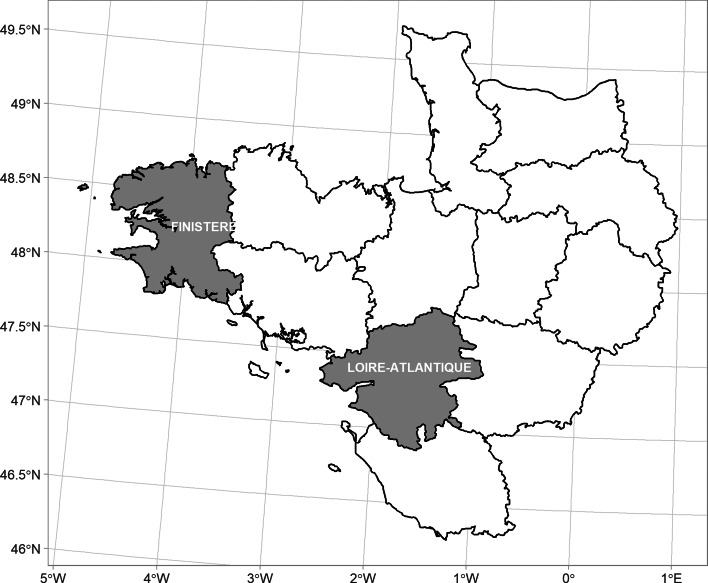
Location of the departments Finistère and Loire-Atlantique in western France.